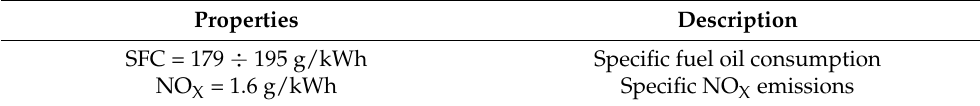
Table 3. MAK VM32-C16 emissions parameters.